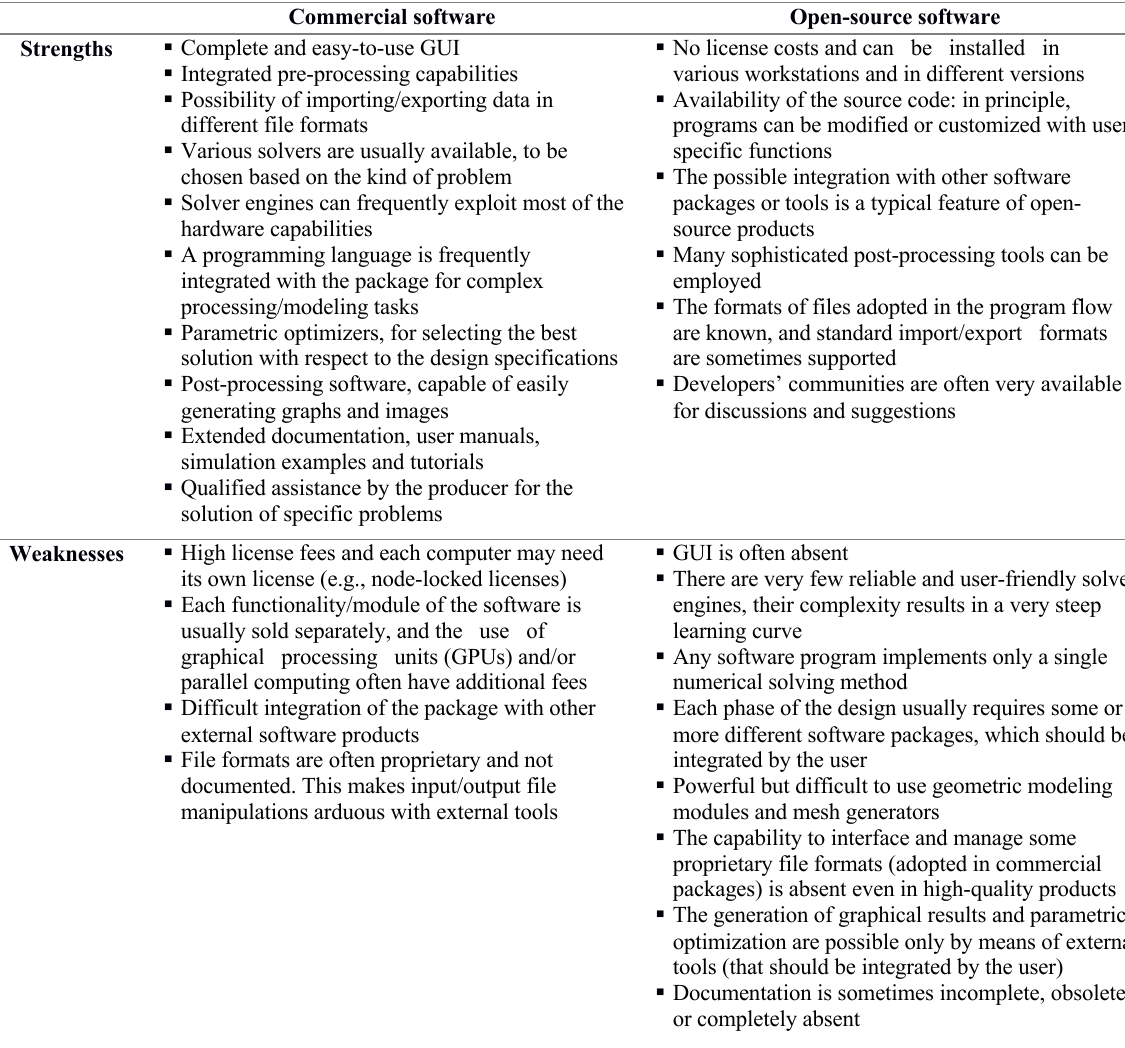
Table V. Pros and cons of open-source vs. commercial software packages for electromagnetic simulation derived from